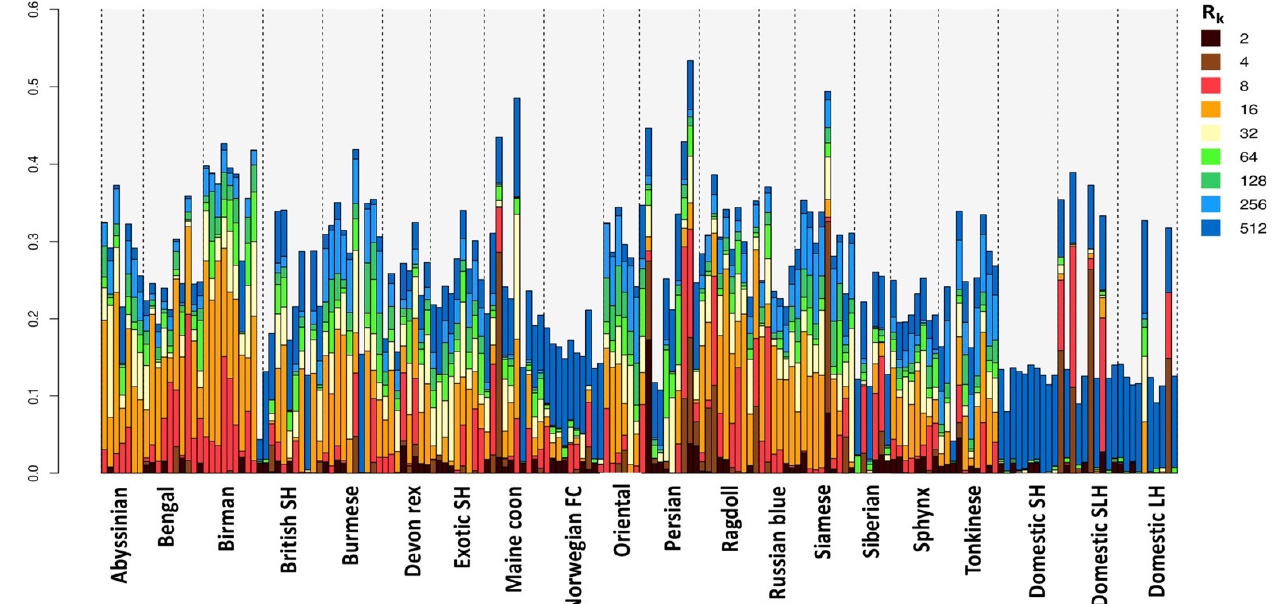
Figure 5. Genomic content of homozygosity by descent (HBD) segments. HBD segments were classified by segments’ ages with respect to inferred generation time. The colour legend indicates the HBD class rates, defined by R k . The rate of a class is equal to twice the number of generations to the common ancestors associated with that class [37] .